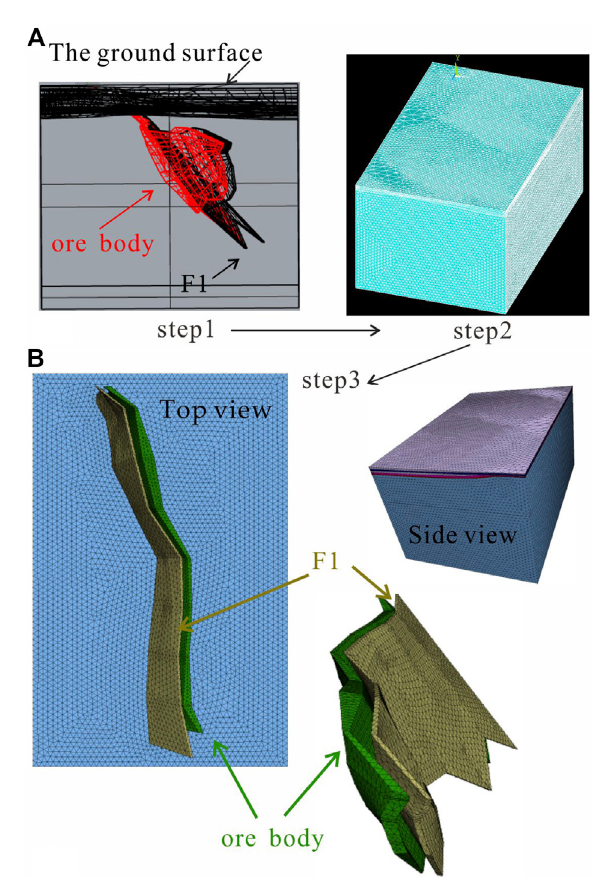
FIGURE 4 Constructed realistic mining models. (A) Modeling process step 1 and step 2; (B) Modeling process step 3.